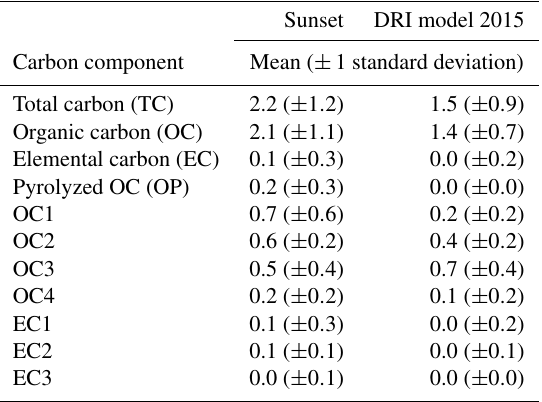
Table 2. Mean and standard deviation (1 σ ) of the carbon mass load- ings (µgcm − 2 ) from 622 field blank measurements by the Sunset and DRI model 2015